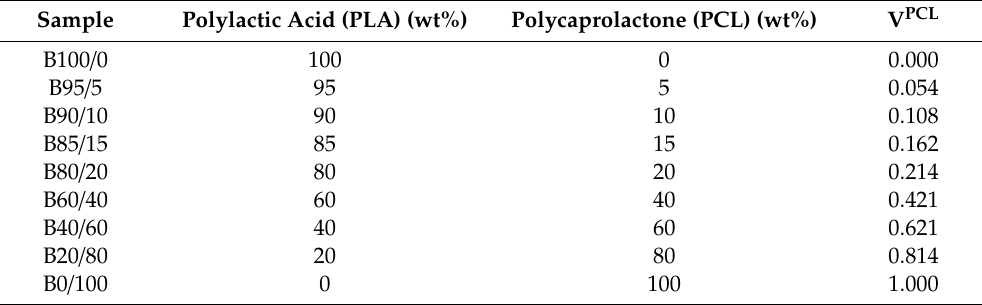
Table 1. Experimental batch of the present